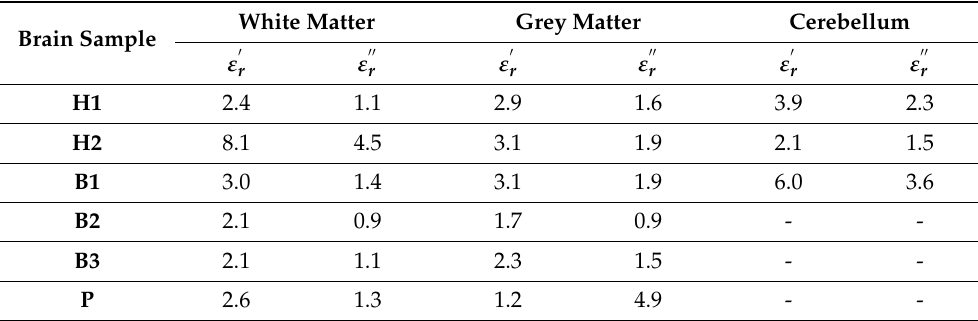
Table 4. Average standard deviation for measured white matter, grey matter and cerebellum of all measured brains. White Matter Grey Matter Brain Sample